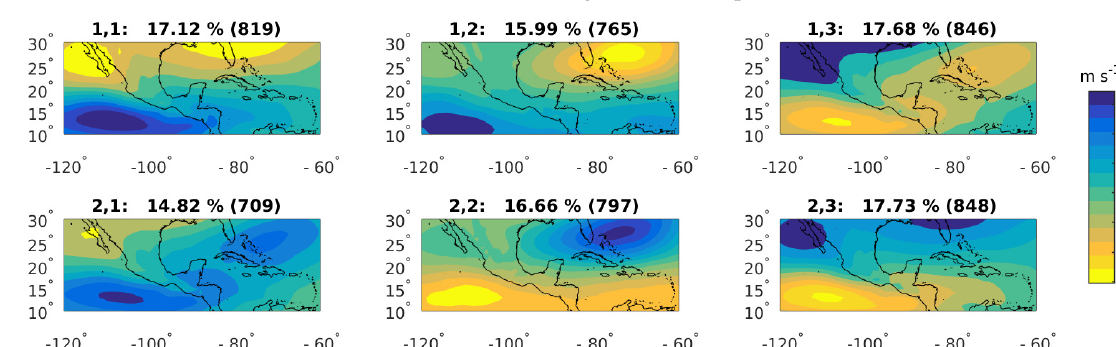
Figure 4. Same as Figure 2, but for component u of wind at 700 hPa.